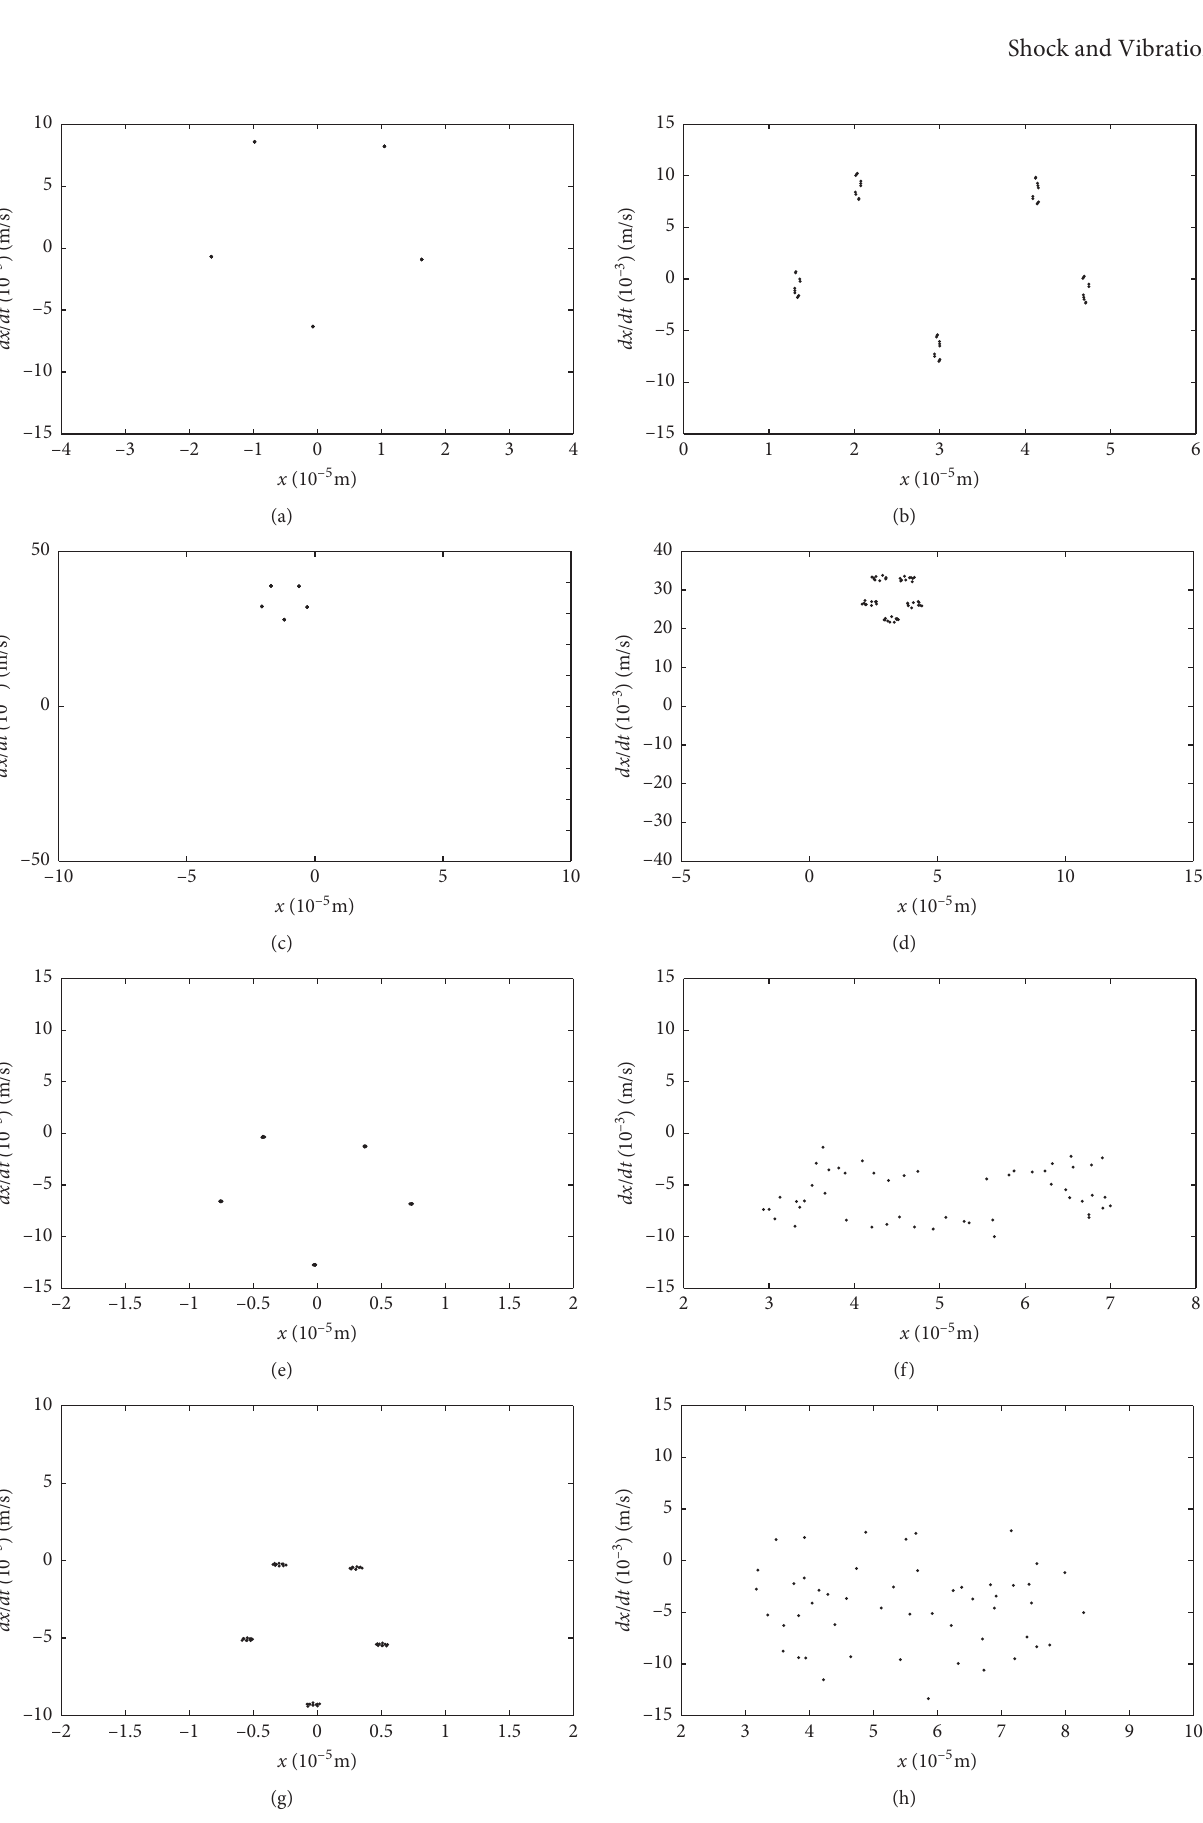
Figure 18: Poincare maps of disk 4. (a) 300rad/s, straight flight. (b) 300rad/s, hovering. (c) 400 rad/s, straight flight. (d) 400rad/s, hovering. (e) 500rad/s, straight flight. (f) 500rad/s, hovering. (g) 550rad/s, straight flight. (h) 550rad/s,